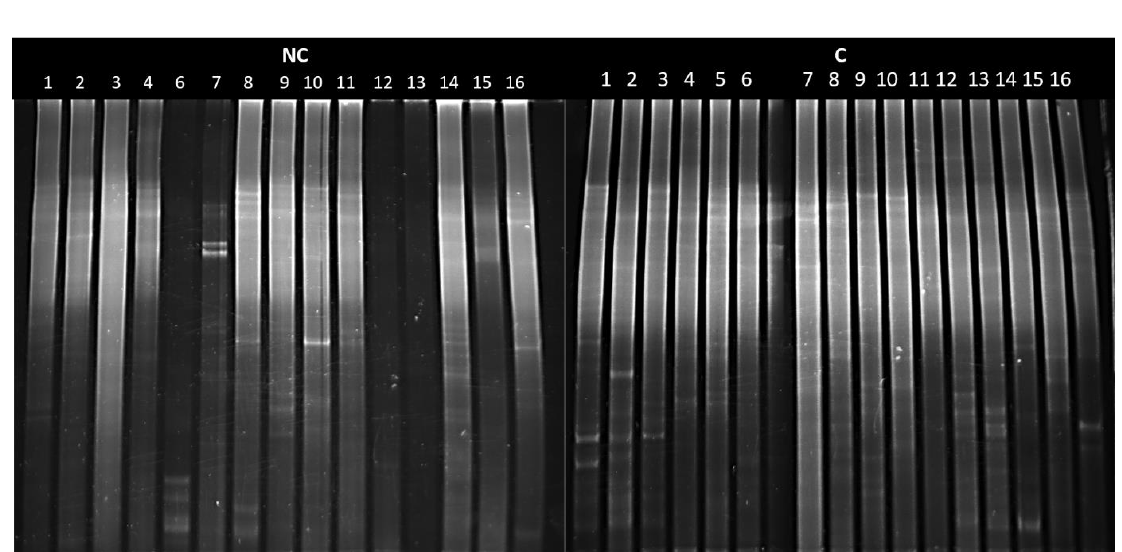
Figure A1. Denaturing gradient gel electrophoresis (DGGE) banding patterns of 16S rRNA gene fragments generated from Actinobacterial DNA amplified by nested PCR isolated from the studied soil samples. NC – non cultivated soils, C – cultivated soils.